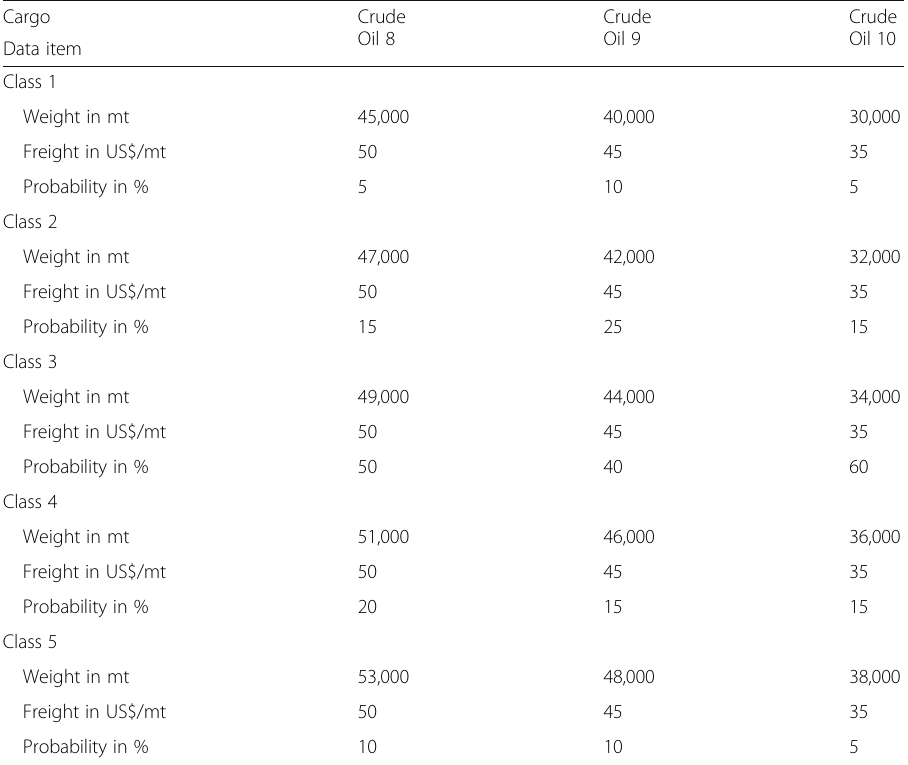
Table 4 Unconfirmed cargo additional data